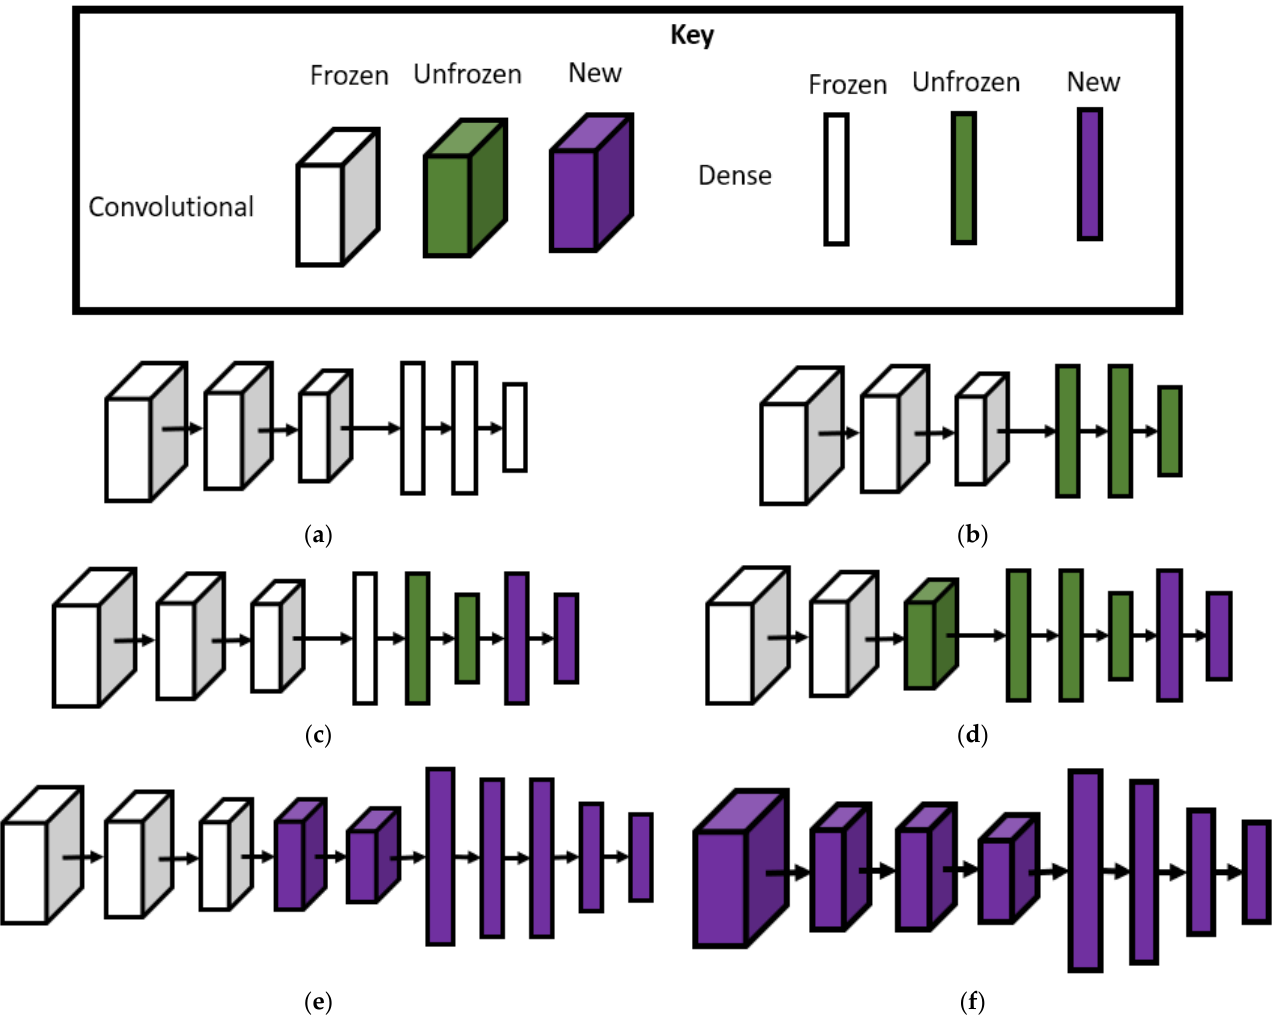
Figure 4. Varying amounts of “knowledge” transferred in a transfer learning application involving ANNs: ( a ) original source mode; ( b ) frozen convolutional layers with unfrozen dense layers; ( c ) frozen convolutional layers with a combination of frozen, unfrozen, and new dense layers; ( d ) combination of frozen and unfrozen convolutional layers and a mix of unfrozen and new dense layers; ( e ) combination of frozen and new convolutional layers with all new dense layers; ( f ) all new convolutional and dense layers, i.e., a completely separate model.